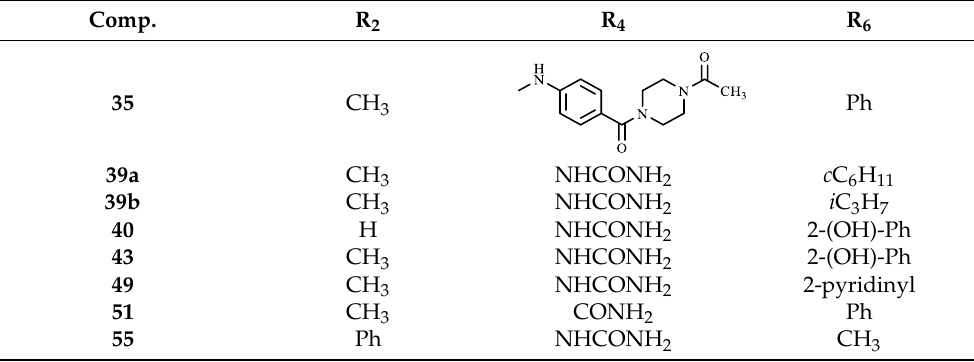
Table 2. Cont. Comp. R